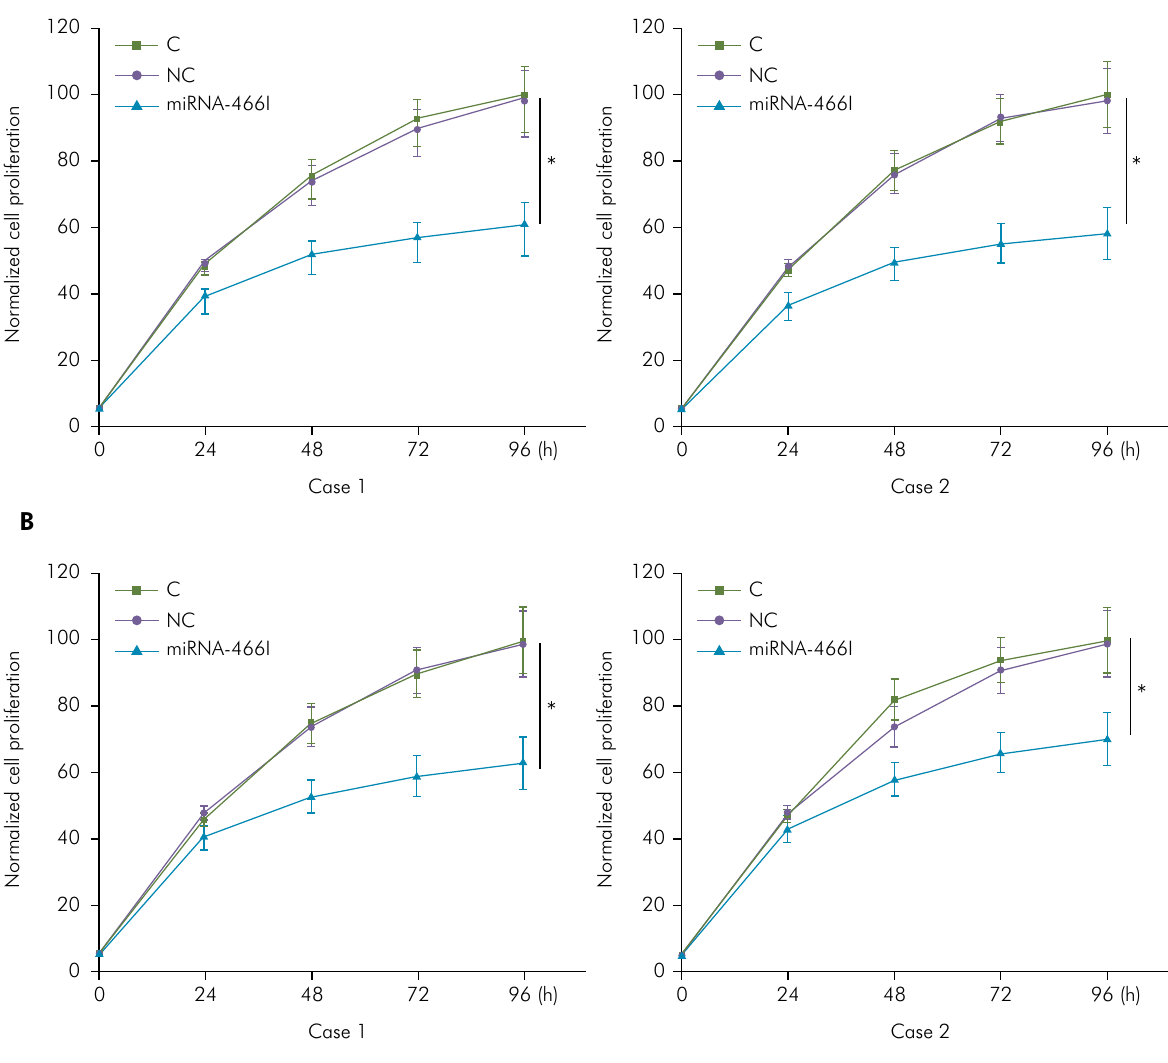
Figure 4. Effects of microRNA-466l overexpression on the proliferation of two cultures of PDLSCs derived from periodontitis-affected teeth (a) and two cultures of PDLSCs derived from healthy teeth